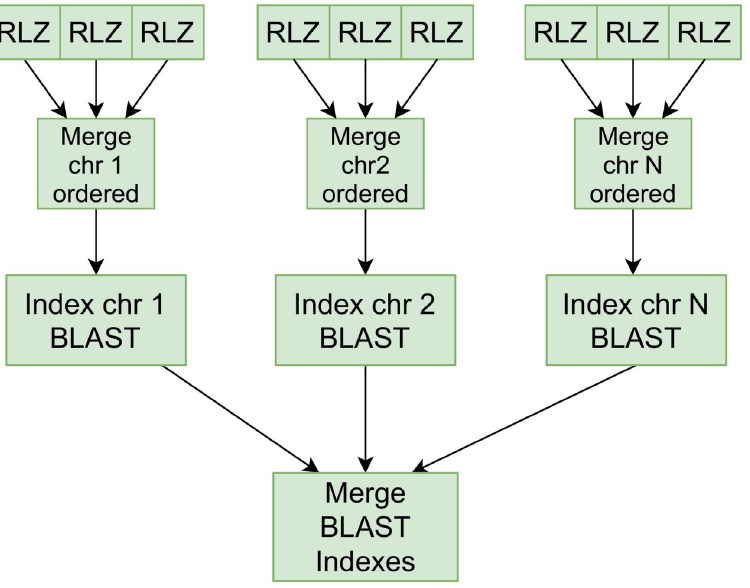
Fig 3. Distributed hybrid-indexing with